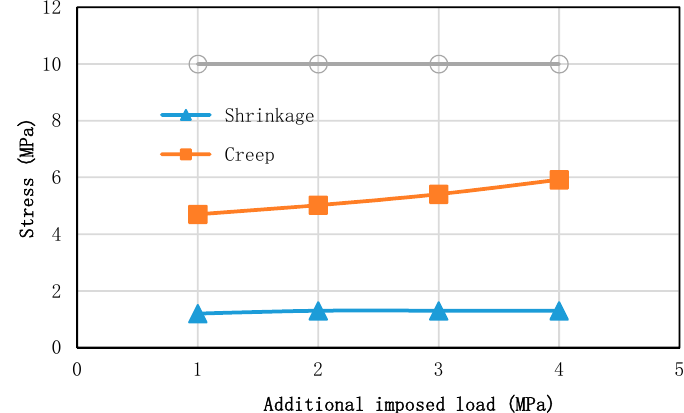
Figure 12. Stress variation in the concrete deck in the hogging region due to different effects for different additional imposed load.